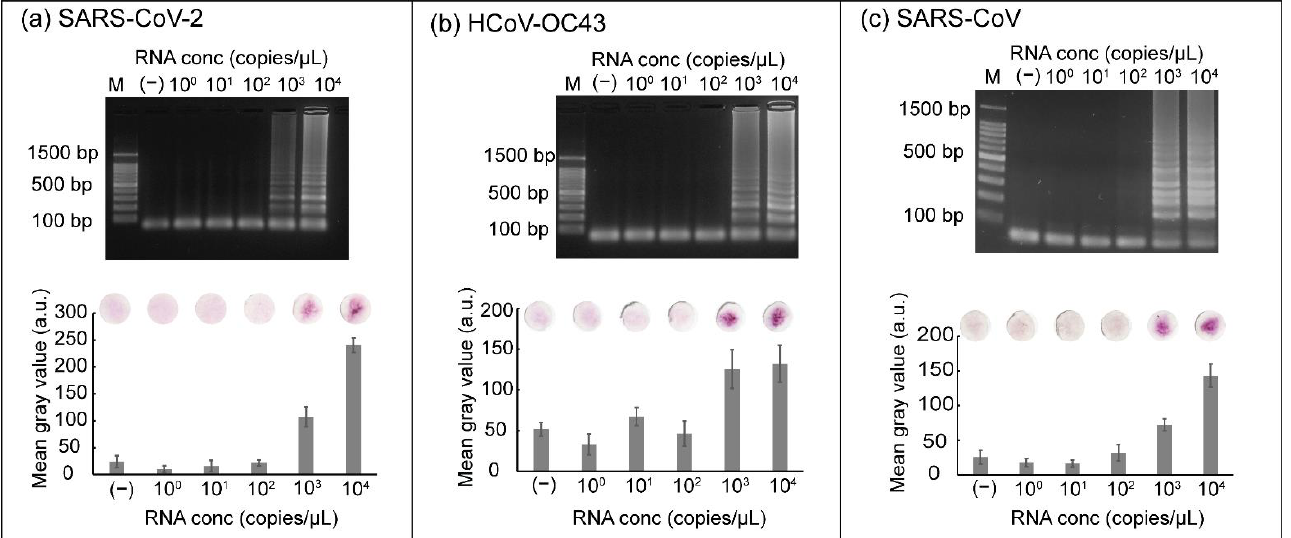
Figure 6. Results showing ( a ) the sensitivity of SARS-CoV-2 detection mediated by carmoisine, ( b ) the sensitivity of HCoV-OC43 detection, and ( c ) the sensitivity of SARS-CoV detection. M represents 100 bp ladder. RNA concentrations ranging from 10 0 to 10 4 copies/µL were used. All experiments were repeated three times.